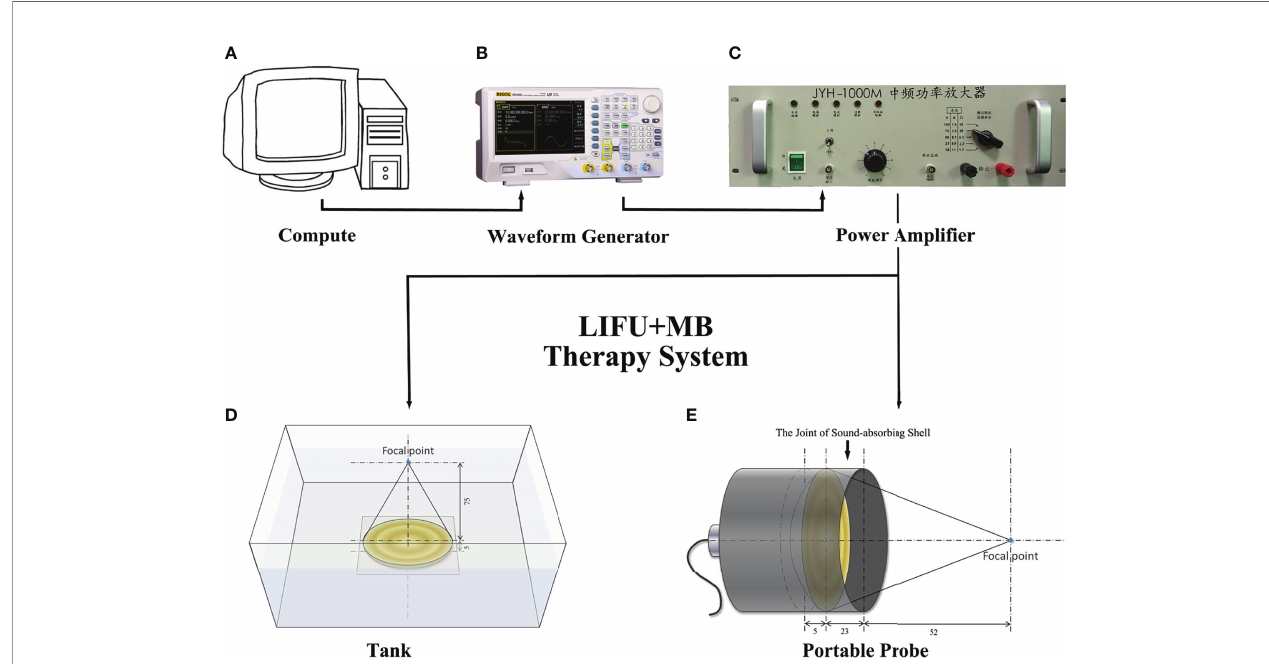
FIGURE 1 | Design of acoustic exposure platform. Illustration of the entire platform setup that includes (A) compute, (B) waveform generator, (C) power ampli fi er, (E) transducer, and (D) the exposure platform immersed within a degassed water bath.